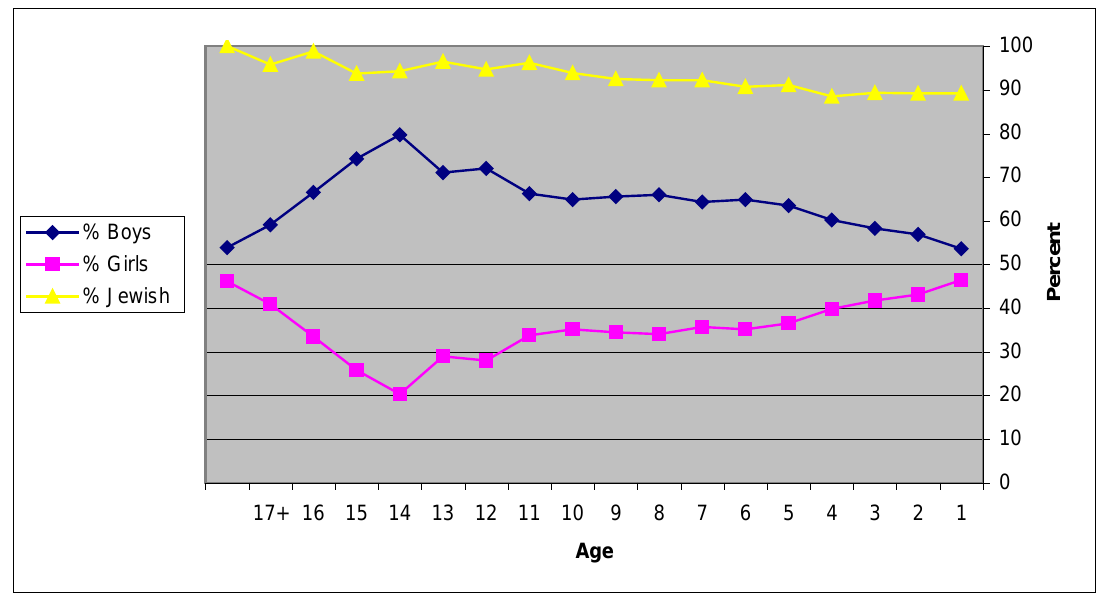
FIGURE 2. Emergency room visits due to injury. Percentage by males, females, and Jews out of total emergency room visits.